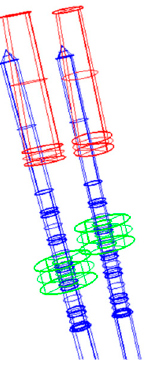
Figure 3. Graphic representation of registered three-dimensional deviations.